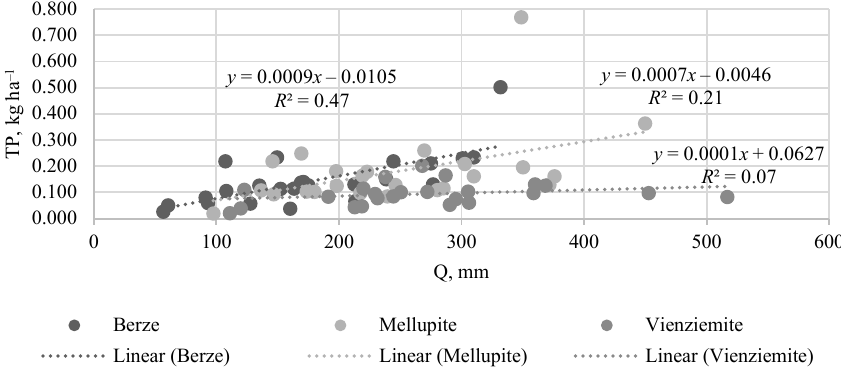
Fig. 8. Scatterplot of the TP losses (kg N ha − 1 ) vs. water discharge Q (mm) in the Berze, Mellupite and Vienziemite subsurface drainage field scale. TP losses in the Berze and the Mellupite subsurface drainage field scale had extreme values. These extreme values were not excluded, because the data collected is unlikely to be inaccurate, this discrepancy is due to the short-term agro-hydrological conditions that have affected